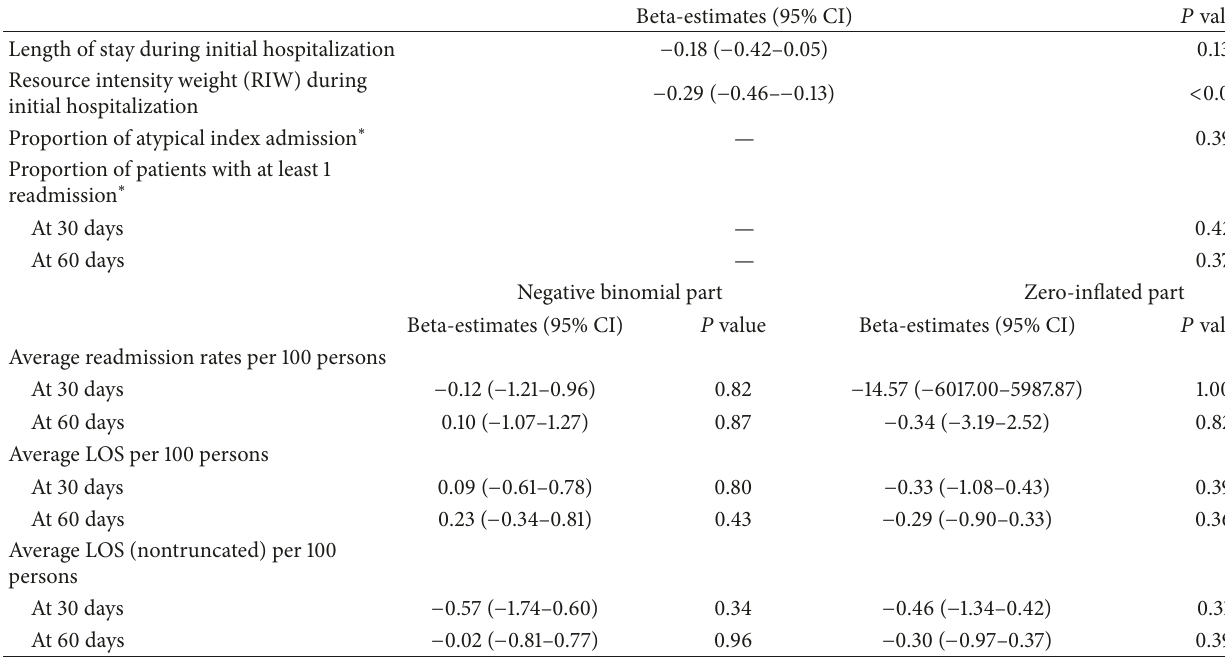
Table 7: Results of the statistical comparisons of the outcomes within the inappropriate COPD comparator